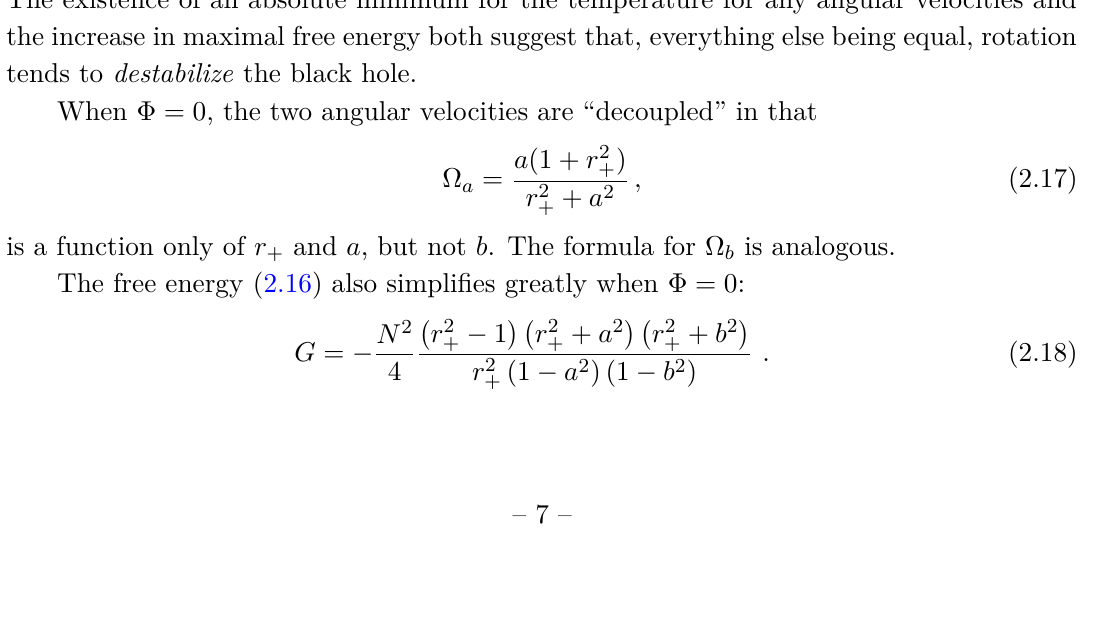
= N 2 . The large black hole branch max 16 = 3 HP 2 π